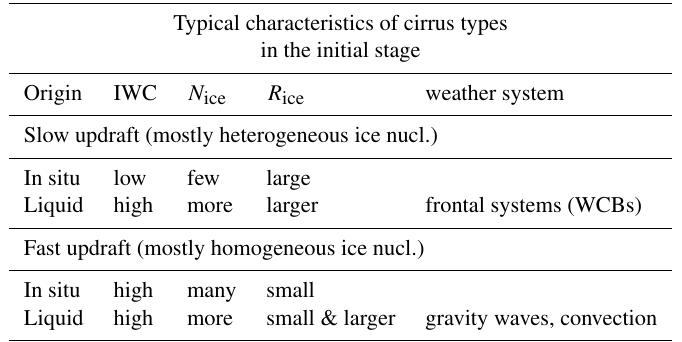
Table 1. Typical characteristics of cirrus types in the initial stage. Typical characteristics of cirrus types in the initial stage Origin IWC N ice R ice weather system Slow updraft (mostly heterogeneous ice nucl.) In situ low few large Liquid high more larger frontal systems (WCBs) Fast updraft (mostly homogeneous ice nucl.) In situ high many small Liquid high more small & larger gravity waves, convection Slow updraft: (cid:46) 10cms − 1 ; fast updraft: (cid:38) 10cms − 1 (Kärcher and Lohmann, 2002; Krämer et al., 2016). IWC high and low: above and below the IWC median (see Fig. 7). N ice